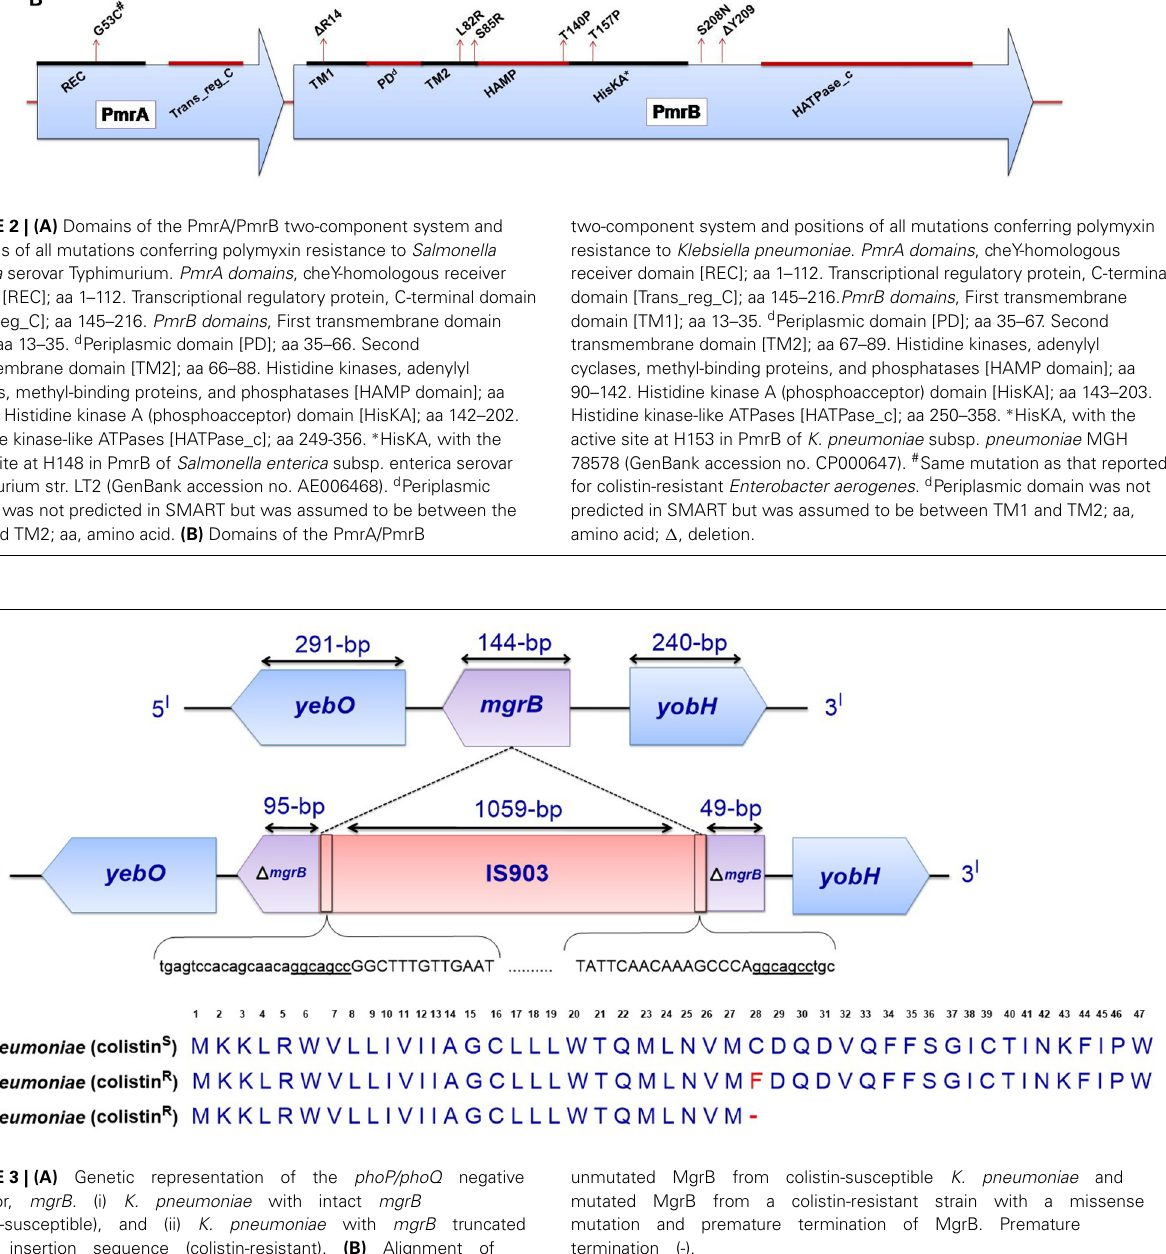
unmutated MgrB from colistin-susceptible K. pneumoniae and mutated MgrB from a colistin-resistant strain with a missense mutation and premature termination of MgrB. Premature termination